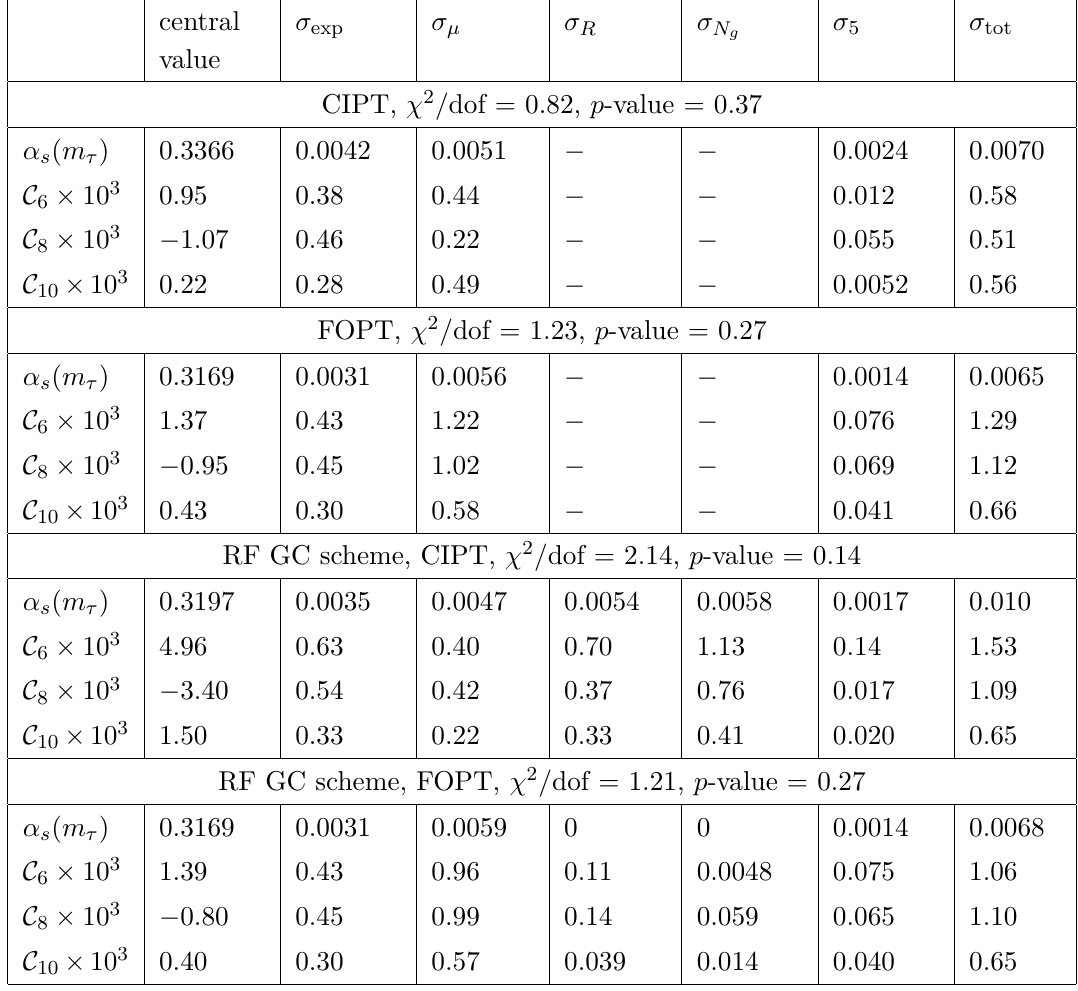
linear term x , all moments are GCS, i.e. the GC OPE correction is highly suppressed